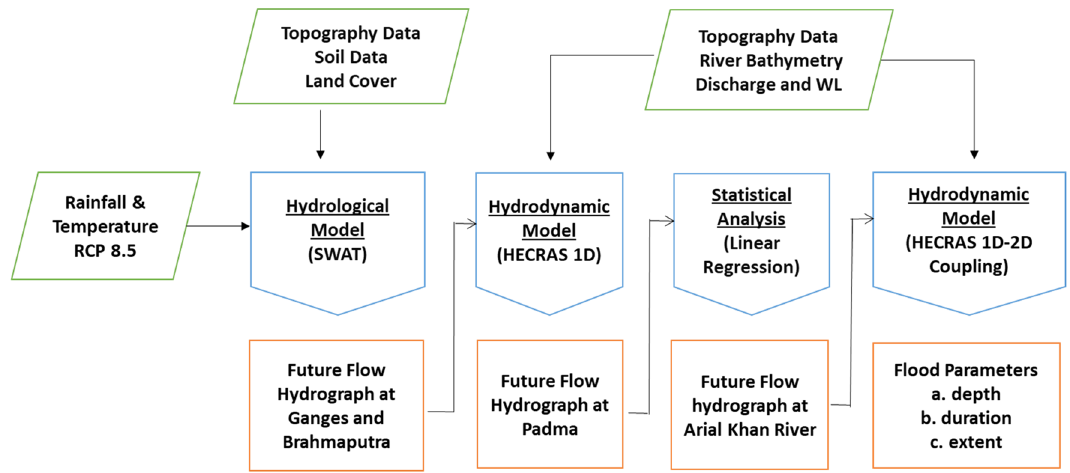
Fig. 2 Step by step model development in graphical flow